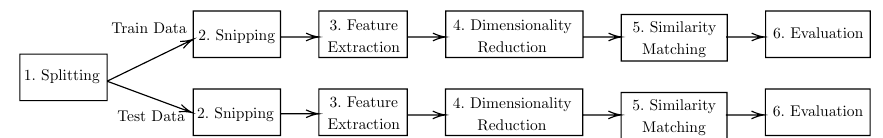
Fig. 1 Data processing pipeline for all scenarios evaluated in this